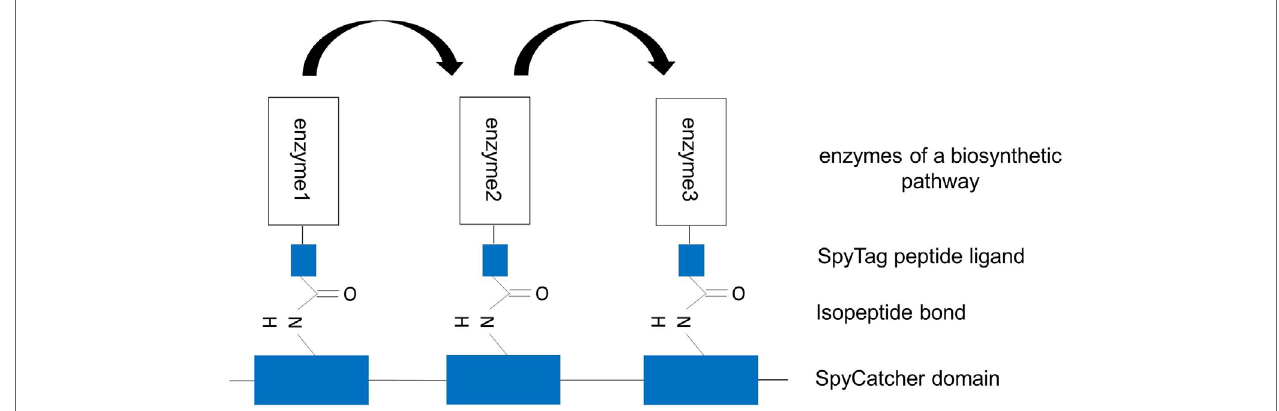
FiGURe 5 | Artificial multienzyme complex by covalently tethering pathway enzymes to the synthetic scaffold via the SpySystem . The protein-based scaffold is based on repeats of SpyCatcher domains. The enzymes to be co-localized are fused to SpyTag peptide ligands. By co-expressing the components, the enzymes were co-immobilized on the scaffold via the covalent, irreversible interaction between SpyCatcher and SpyTag (isopeptide bond). Metabolic channeling between the single enzymes (indicated by the arrows) should be